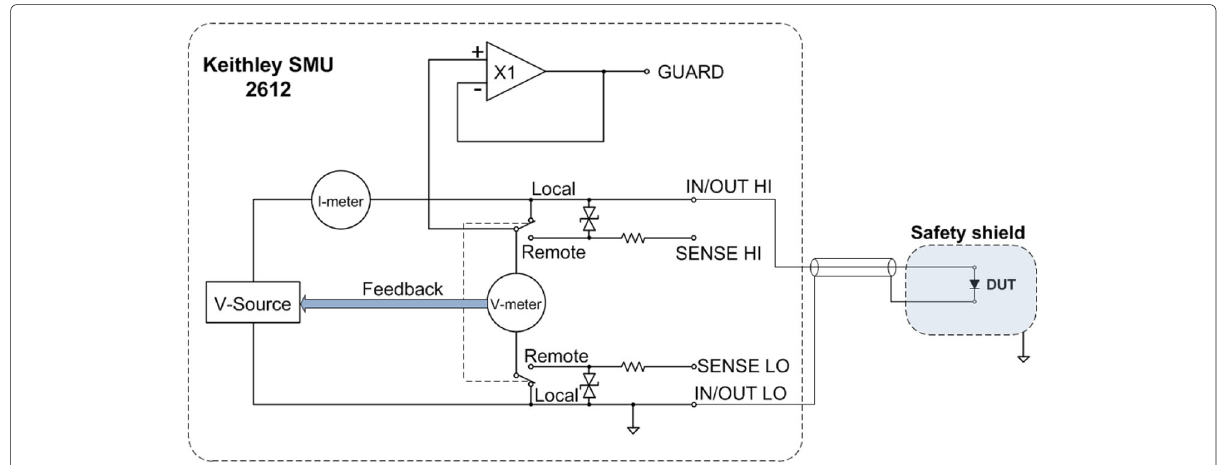
Fig. 1 Measurement setup: Keithley source-measure unit configured as a constant voltage source with a safety shield